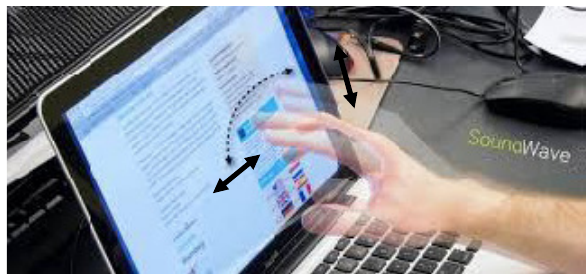
Figure 1. An illustration of hand gesture recognition via sound waves used to control applications on laptop.